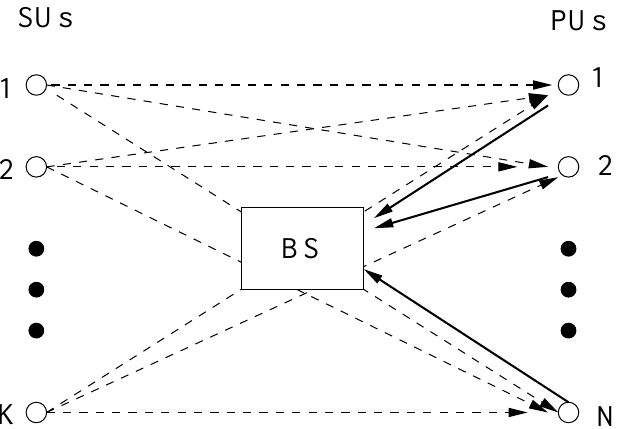
Figure 3. PUs to BS and signals from SUs as the